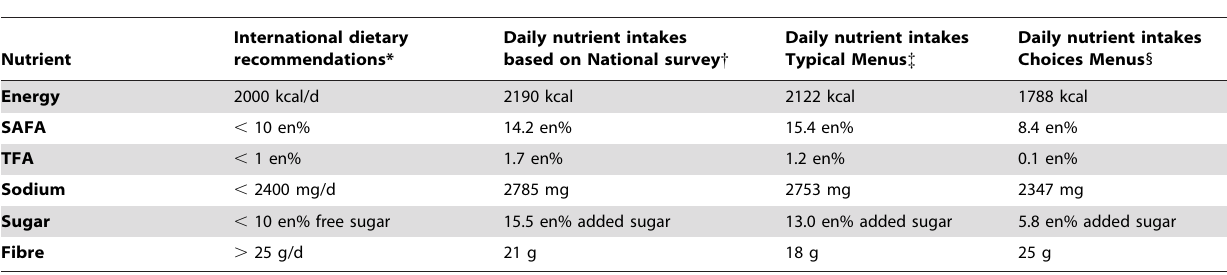
Table 1. Daily Menu Method: Example from The Netherlands [14,15].